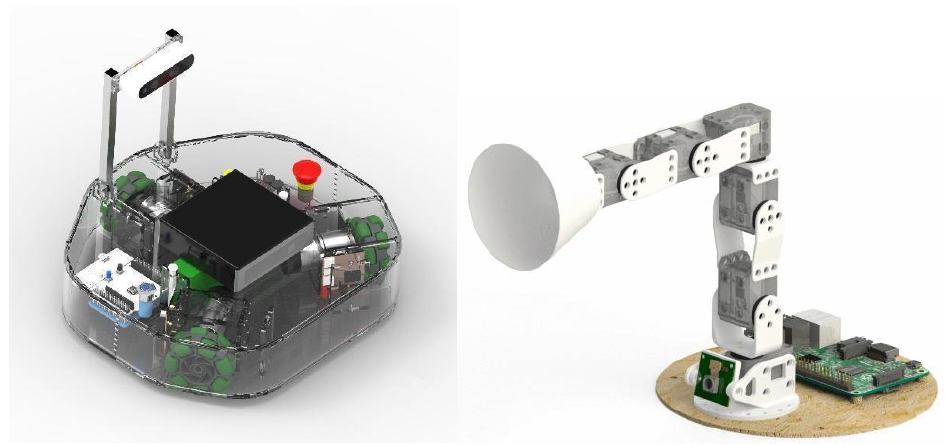
Figure 2. ClearBot ( left ) and Poppy Ergo Jr ( right ).